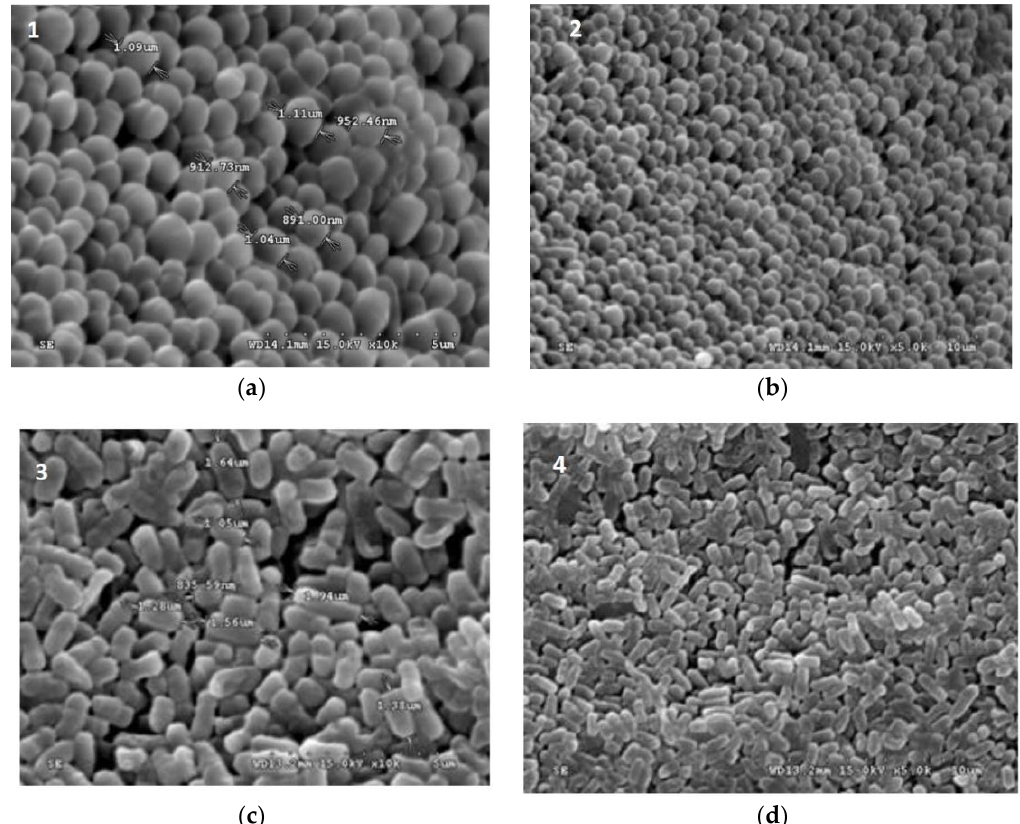
Figure 1. Scanning electron micrograph (SEM) of freeze dried ( a ) L. plantarum , ( b ) L. paraplantarum , ( c ) W. paramesenteroides , and ( d ) E. faecalis .